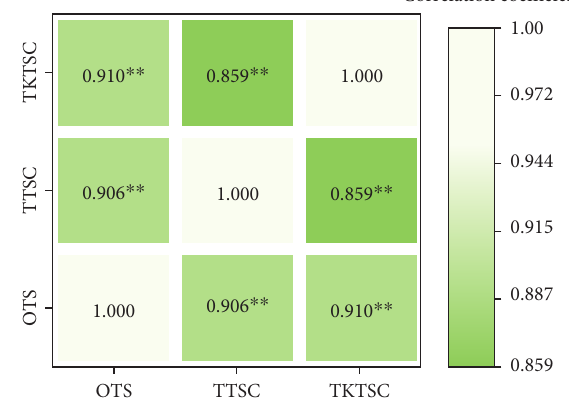
Figure 10: The relevance analysis of DRT in